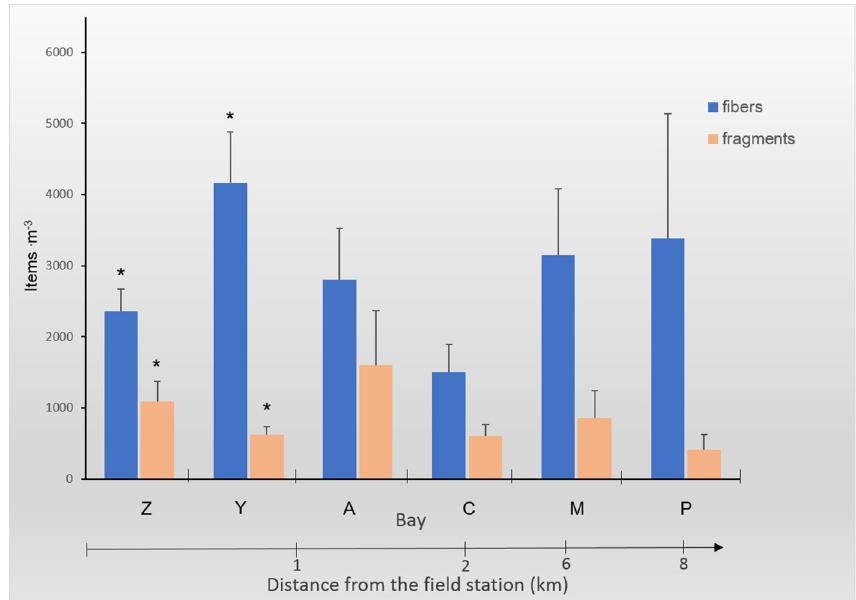
Figure 2. The mean number (particles · m − 3 ) of the fibers and fragments found in the surface water of the studied bays of the Barents Sea: (A) Avarijnaya, (C) Plokhie Chevry, (M) Medvezhya, (P) Porch- nikha, (Y) Yarnyshnaya, and (Z) Zelenetskaya. The distance (in km) from the field station is shown by the arrow at the bottom of the graph. The error bars represent ± 1SE. Statistically significant differences are indicated by * p < 0.05.